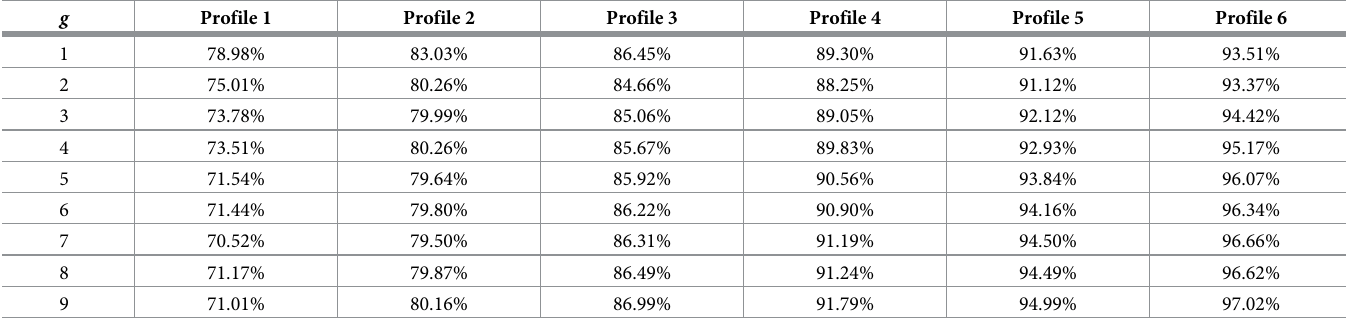
Table 6. Marginal effects.